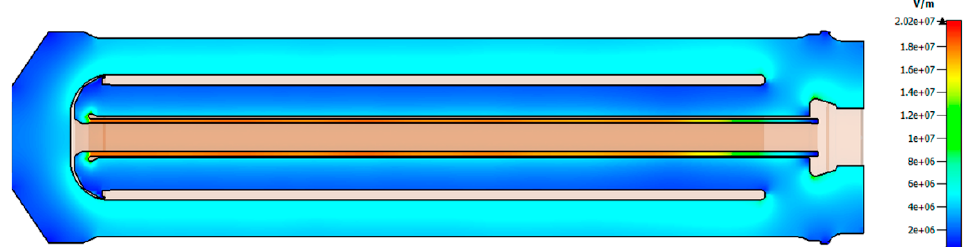
Figure 9. Field distribution in TWFL at discharge point 25 ns.